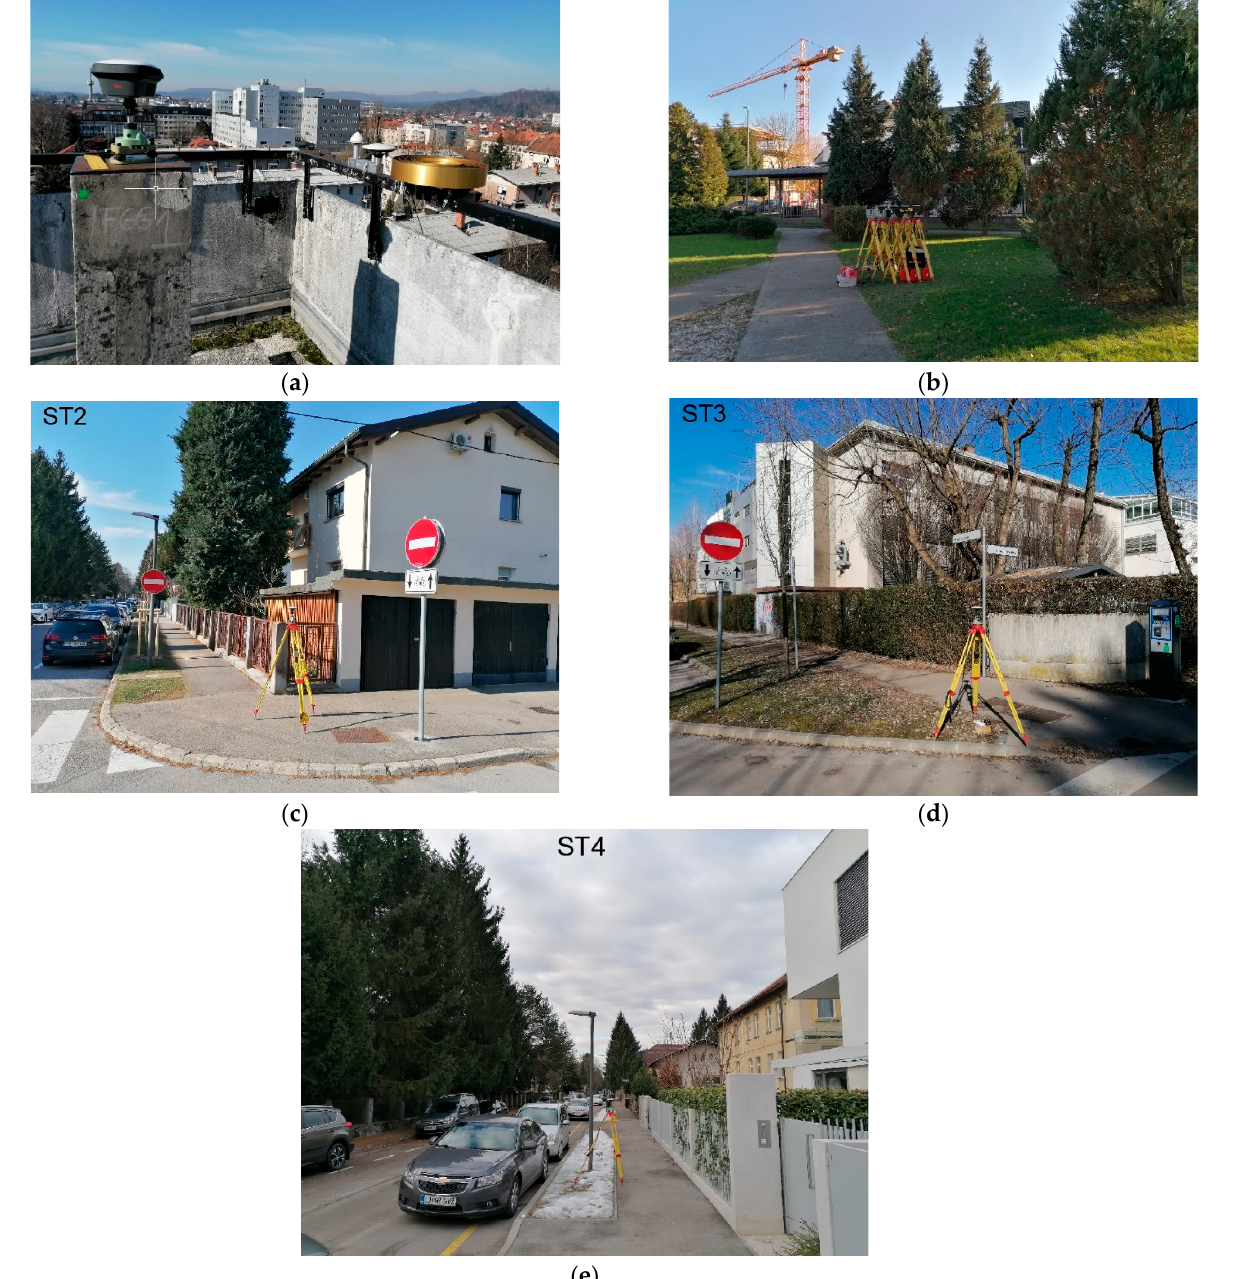
Figure 3. Location of measuring stations: ( a ) LC − 1, LC − 2, and GD − 1 in ST 1; ( b ) LC − 1, LC − 2, and GD − 1 in ST 1A; ( c ) LC − 1 in ST 2; ( d ) LC − 1 in ST 3; and ( e ) LC − 1 in ST 4.